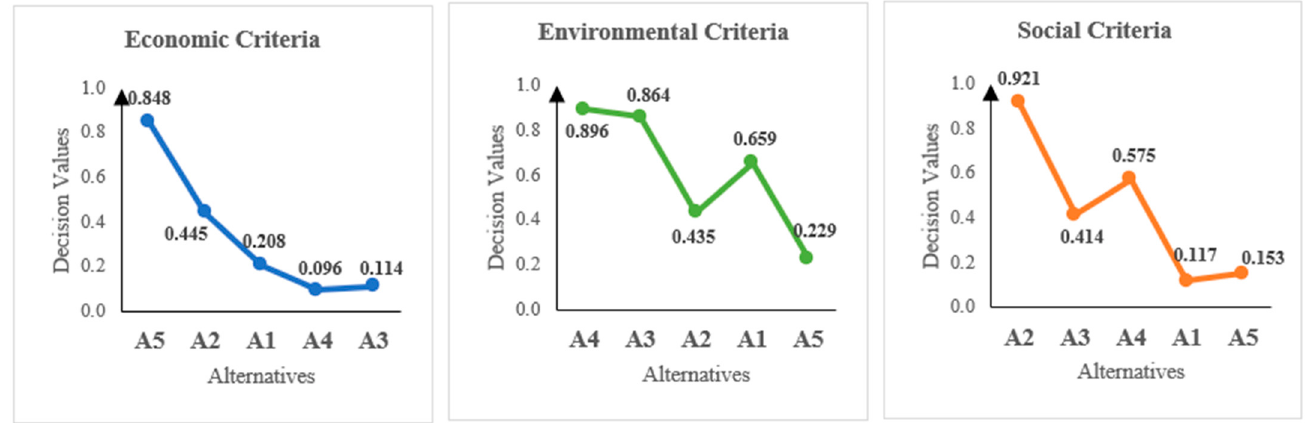
Figure 5. Results of the TOPSIS method for different aspects of sustainability.